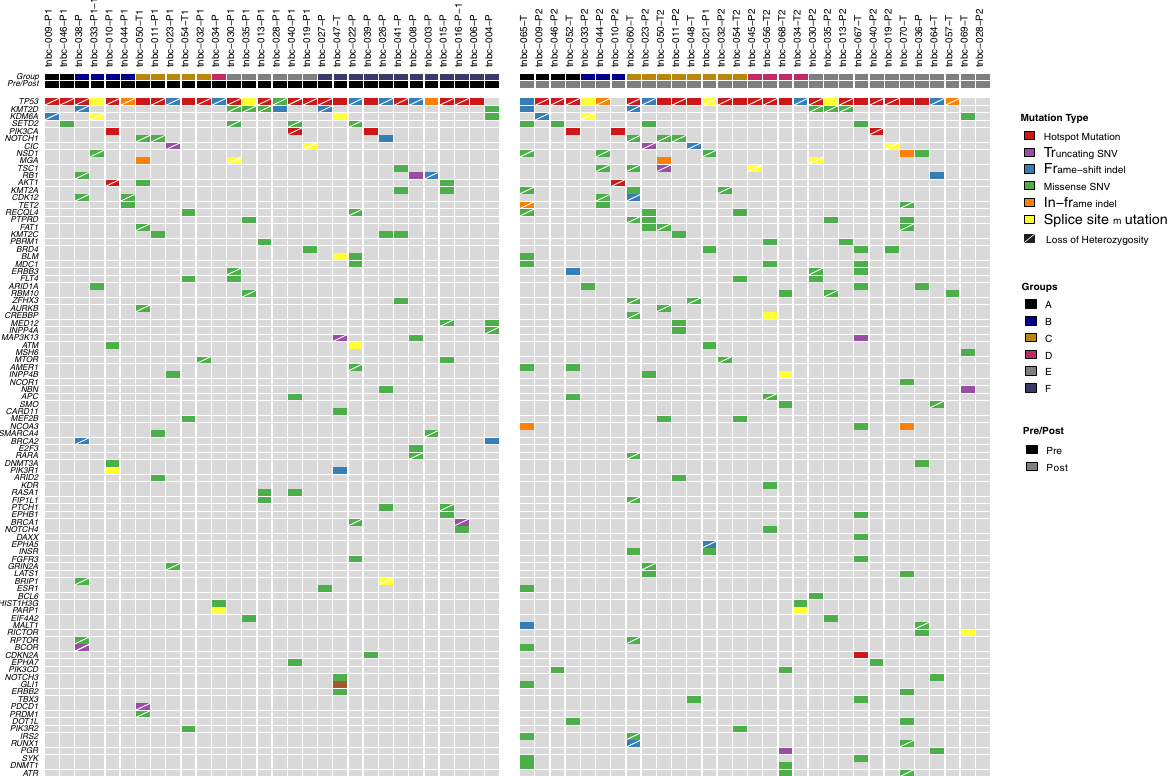
Fig. 1 A heatmap depicting somatic mutations in 61 pre/post-treatment TNBC samples. Samples are shown as columns and are ordered by pre/post status and by the group. Genes that were altered in ≥ 2 samples are shown with colored squares corresponding to the colors in the legend. A rapidly recurring tumors (<1 year post-surgery); ( B ) tumors with standard recurrences (1 – 5 years after surgery); ( C , D , and E ) tumors without pathological complete response (pCR) to neoadjuvant treatment (NAT) and without recurrences; ( F ) tumors with pCR to NAT and without recurrences. Samples are presented by MSK-IMPACT assay identi fi ers ( X -axis of the heatmap, identi fi ers of type tnbc-123-A or tnbc-123-AB).